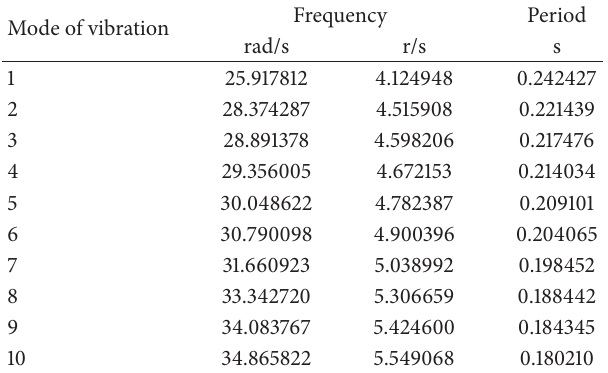
Figure 5: Sine motor vehicle load curve oscillogram.